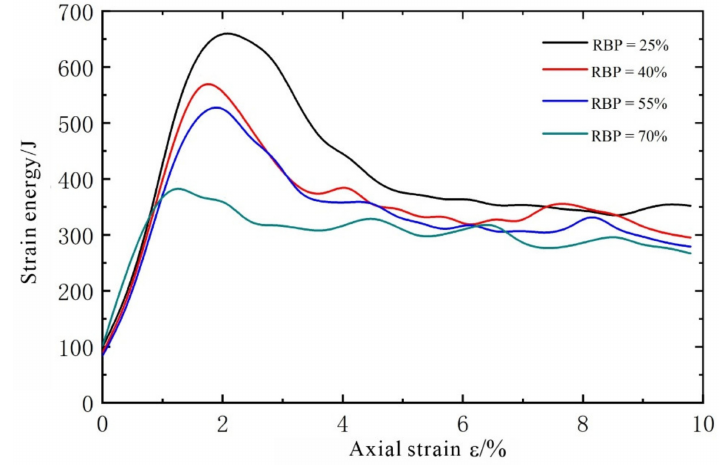
Figure 11. Relationship between strain energy and strain.